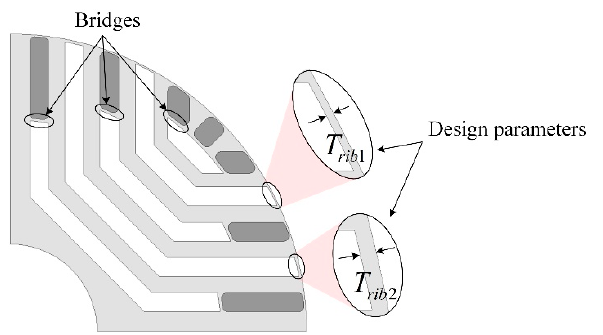
Figure 11. Design parameter for the power factor and safety factor.